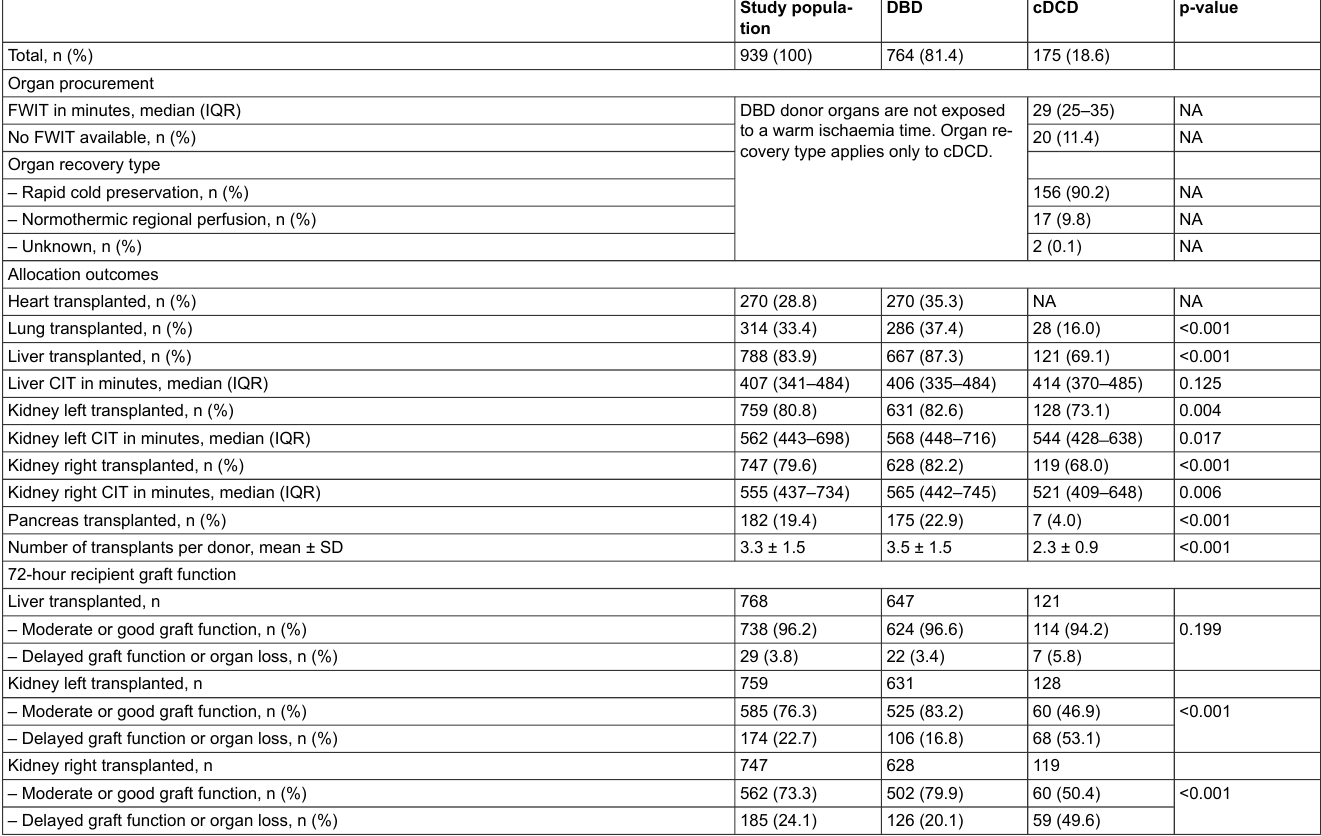
Table 2: Circumstances of organ procurement of utilised cDCD, allocation outcome and early (72-hour) recipient graft function (liver and kidneys) of utilised DBD vs cDCD donors in Switzerland from 2011 ̶ 2019. The maximum possible number or organs transplanted per DBD donor is seven (heart, double lung, liver, two kidneys, pancreas and small bowel). The maximum possible number or organs transplanted per cDCD donor is six (double lung, liver, two kidneys, pancreas and small bowel; no heart procured during study period). Please note that organ loss as included in the early recipient graft function category “delayed graft function or organ loss” occurred very rarely (19 lost livers, 20 lost